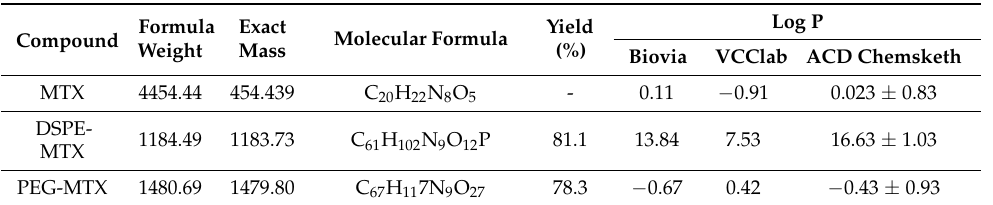
Figure 1. Synthesis of DSPE-MTX and PEG-MTX. Table 1. Formula weight, exact mass, molecular formula, log P value (Bovia, VCClab, ACD chems- keth) of MTX and its